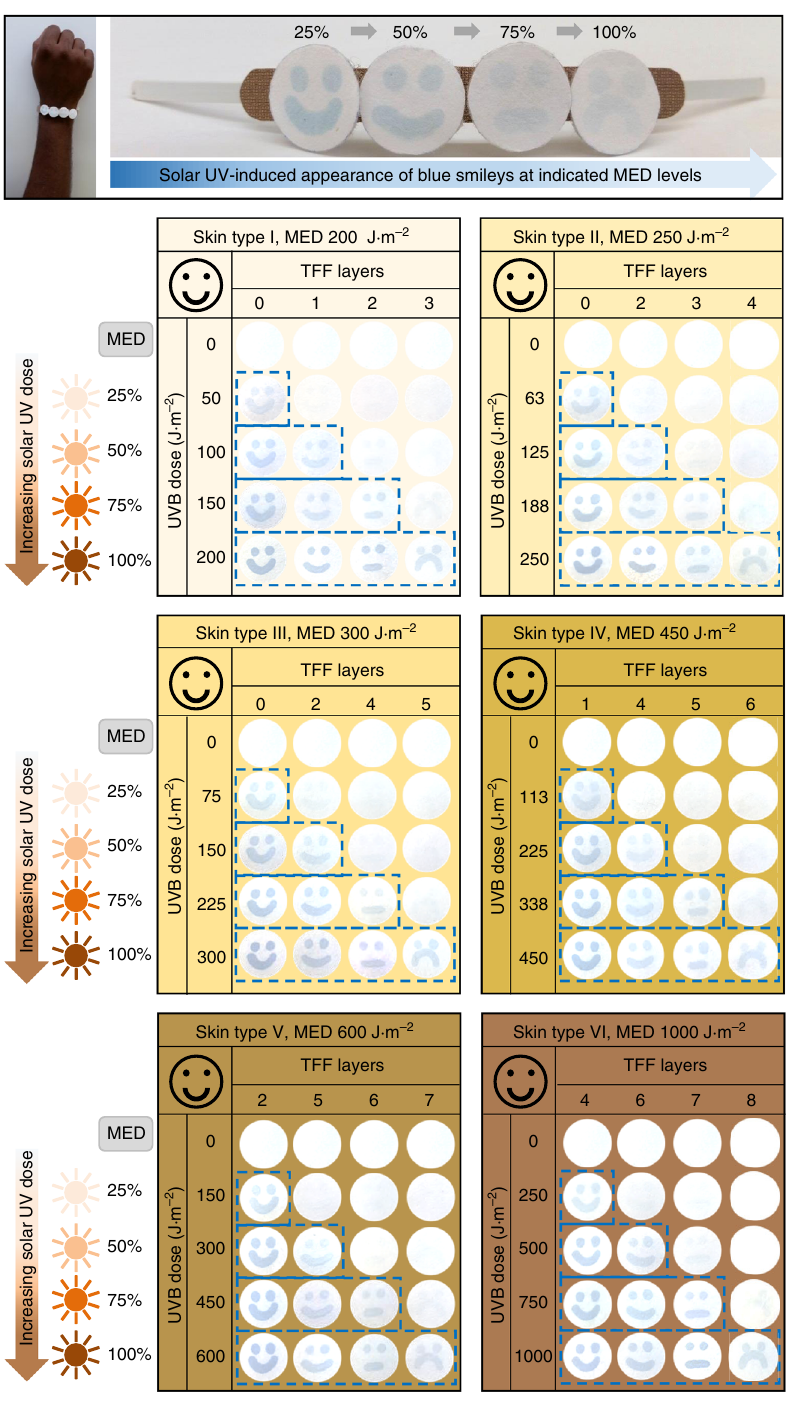
Fig. 5 Design and performance of skin-phototype-speci fi c personalized UV sensors. The top panel shows a paper-based solar UV sensor prototype for a skin type V person in a wristband format after 100% MED exposure. Sensor design incorporates four paper disc-based smileys, each covered with different layers of TFF, and attached to a fl exible wearable band. The smileys are initially invisible, but as the wearer is increasingly exposed to safe solar UVB thresholds of 25%, 50%, 75%, and 100% MED of that particular skin color, the smileys turn blue from left to right, respectively. The colored smileys correspond to total effective solar UV dose. This is demonstrated through assessing the performance of six customized sensors in simulated solar light (bottom six panels), assuring that sensors meet the wide-ranging UVB MED thresholds of people with different skin colors. The skin-phototype speci fi city is achieved by an appropriate combination of the smiley paper discs coated with different TFF layers (0 – 8) in a single sensor that allows